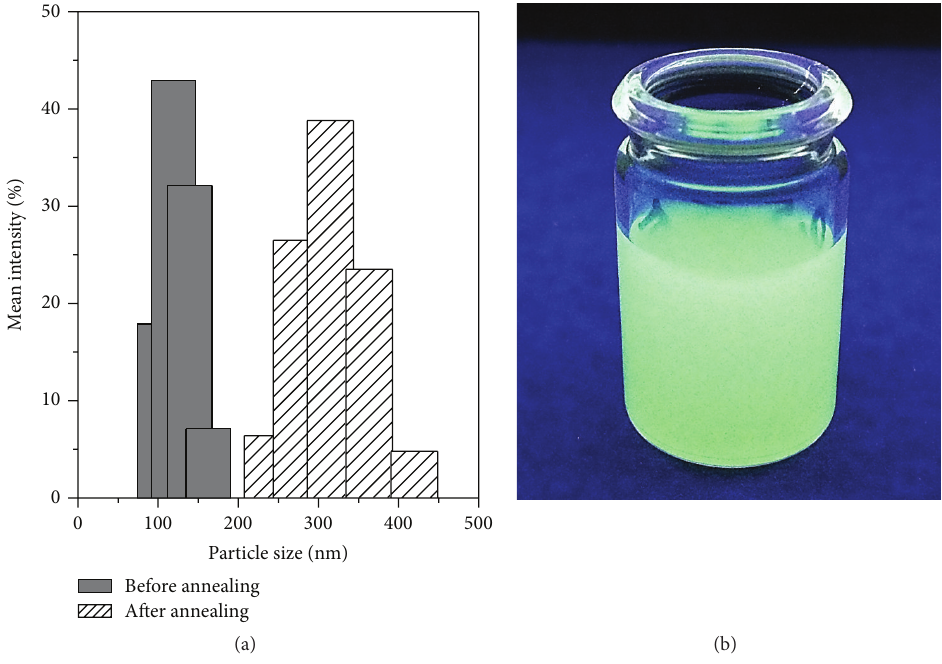
Figure 2: (a) Particle size distribution of SrAl 2 O 4 :Eu NPs, before and after annealing. (b) Ethanolic suspension of SrAl 2 O 4 :Eu 2+ NPs under UV light.